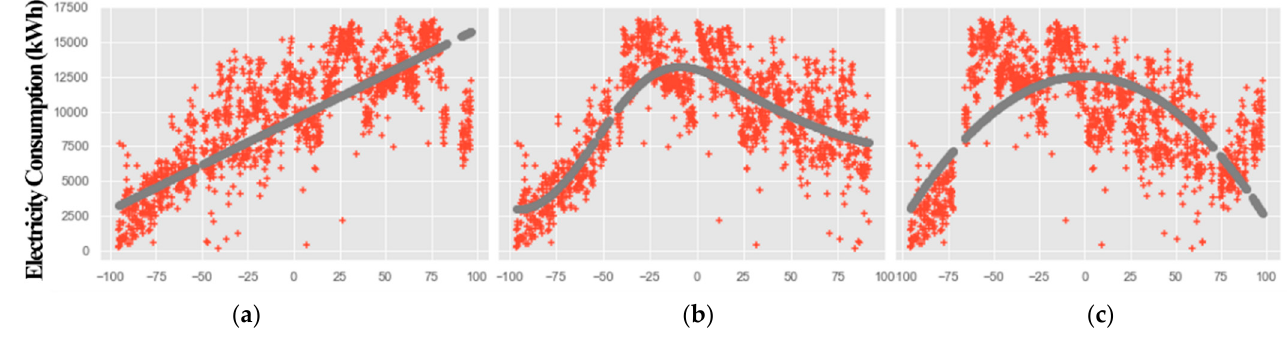
Figure 9. Scatterplot of the SVR-based Electricity Usage Prediction Model: ( a ) SVR–Linear, ( b ) SVR–RBF, and ( c ) SVR–Polynomial.